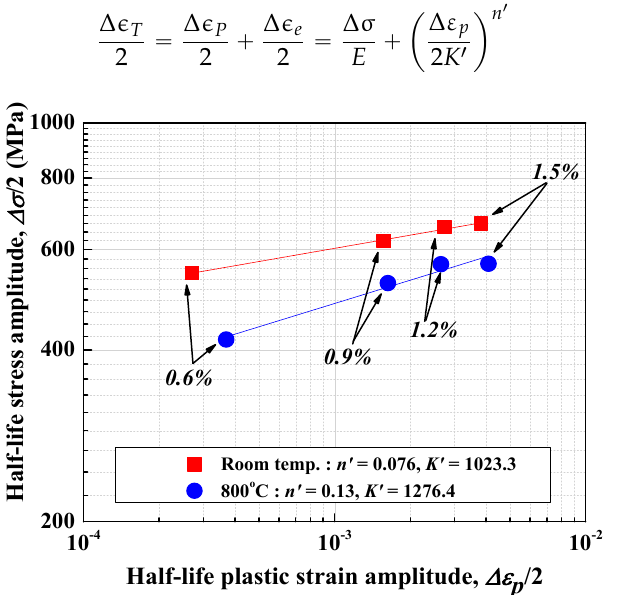
Figure 5. The cyclic stress-plastic strain curves of Alloy 617 weldments at room temperature and 800 °C.